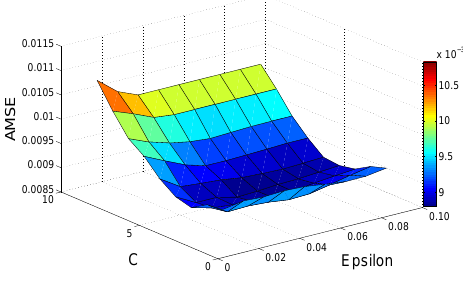
Fig. 7. The values of AMSE based on C , e , when s = 0 . 007. Through the approximate calculation, the opti- mal values of parameters focus on the fields that s ∈ [ 0 . 001 , 0 . 10 ] , e ∈ [ 0 . 01 , 0 . 10 ] , C ∈ [ 1 , 10 ] . The grid method, that calculating the AMSE at each point in parameter space, is used to find the op- timal values. The minimal AMSE is at the point ( s , e , C ) = ( 0 . 007 , 0 . 03 , 6 ) , the final optimal